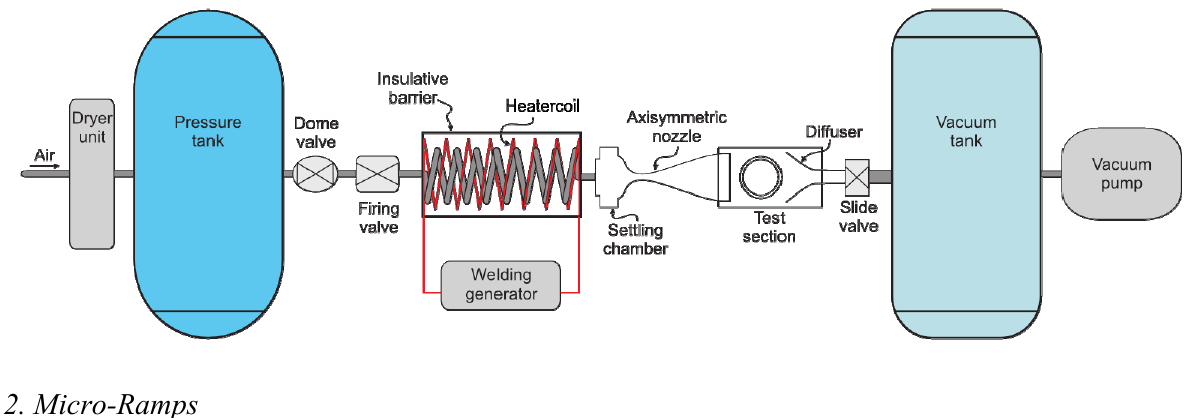
Figure 1. Schematic layout of the Aero-Physics Laboratory high supersonic tunnel (HSST).